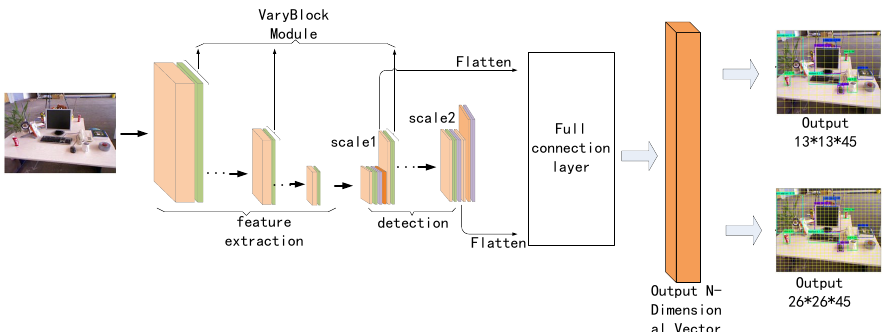
Figure 1. Improved YOLOv3-Tiny object detection algorithm